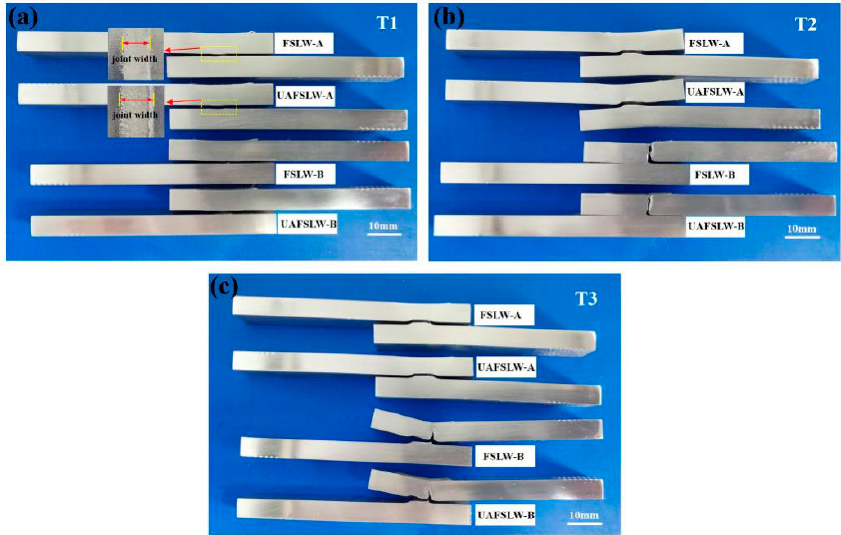
Figure 12. Fracture positions of FSLW and UAFSLW joints: ( a ) FSLW and UAFSLW welded by tool T1, ( b ) FSLW and UAFSLW welded by tool T2, and ( c ) FSLW and UAFSLW welded by tool T3.